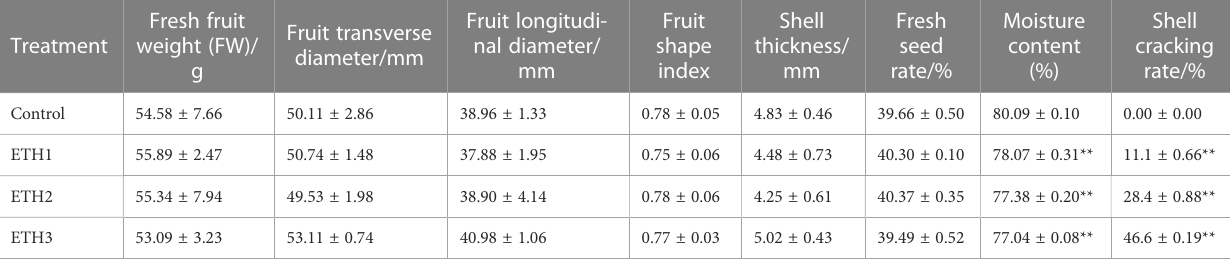
TABLE 3 Fruit phenotypic traits of the three ethephon treatments and the control in ‘ Huashuo ’ .